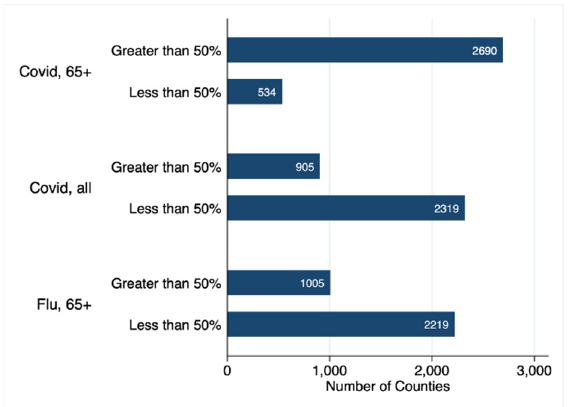
Figure 1. This bar graph shows the number of counties in the United States reaching the 50% vacci- nation threshold for COVID-19 vaccinations in the 65 and older population, COVID-19 vaccinations across all eligible ages, and for influenza vaccinations in the 65 and older